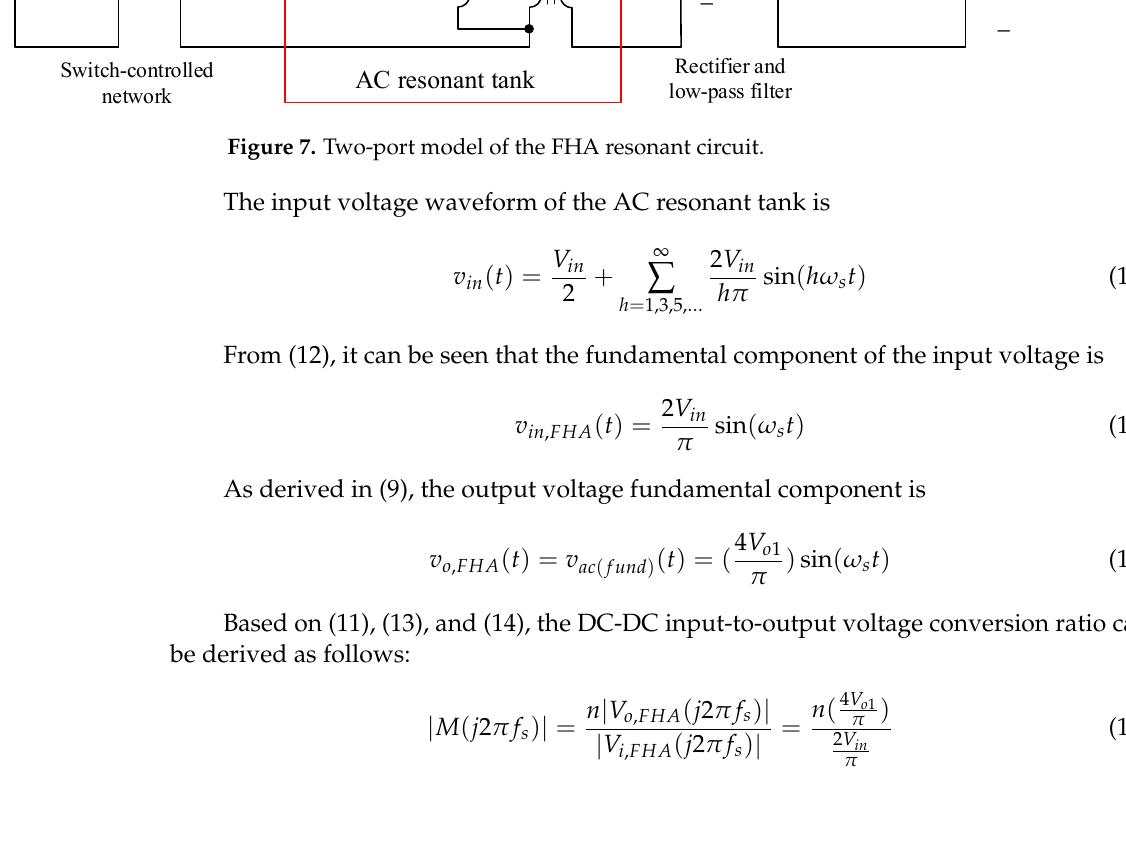
Figure 8. Two-port model of the FHA resonant circuit with one LED string at the output terminals. From (19), it can be seen that the LED current can be regulated by changing the switching frequency f s , and this means that the gain adjustment is made by frequency modulation. As seen in Figure 9, by giving an LED current command I LED _ command , the fre- quency modulator will change the switching frequency f s , and v o , FHA will be varied to a corresponding value according to the designed voltage gain M .